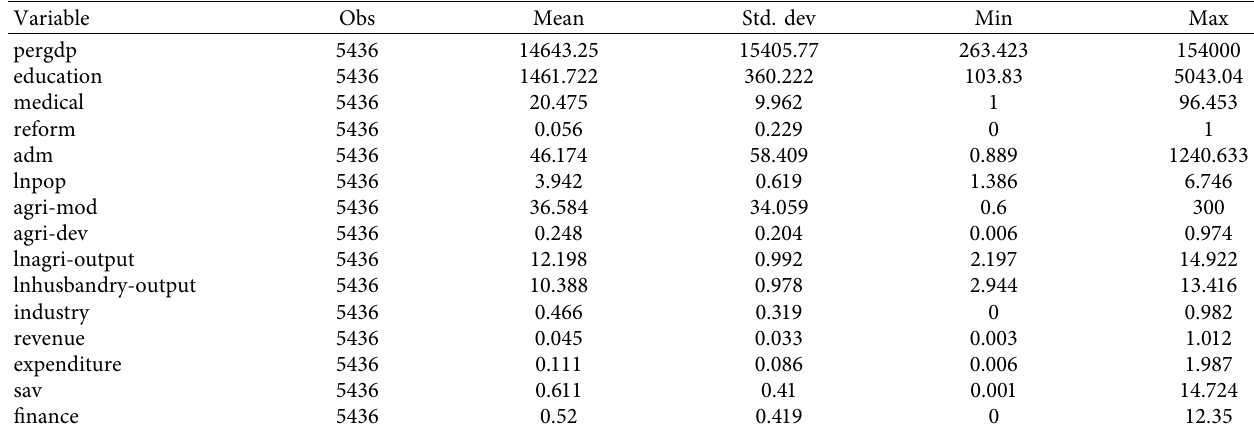
Table 2: Descriptive statistical results.